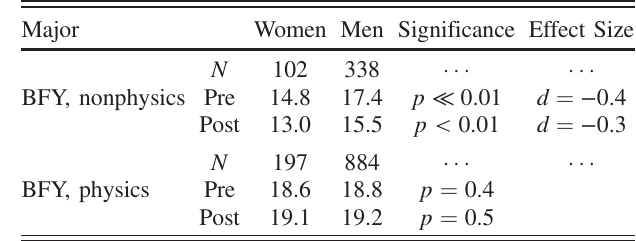
TABLE VIII. Overall E-CLASS scores (points) for men and women on both the pre- and post-tests for the BFY physics and BFY nonphysics student populations separately. Significance indicates the statistical significance of the difference between women ’ s and men ’ s scores.